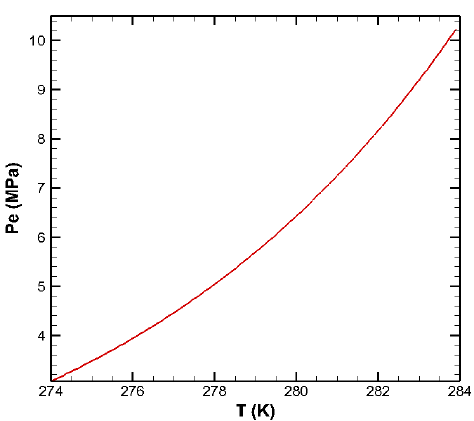
Figure 1. The equilibrium pressure corresponding to the current temperature within the range of 274 K to 284 K. Red line shows the critical line.